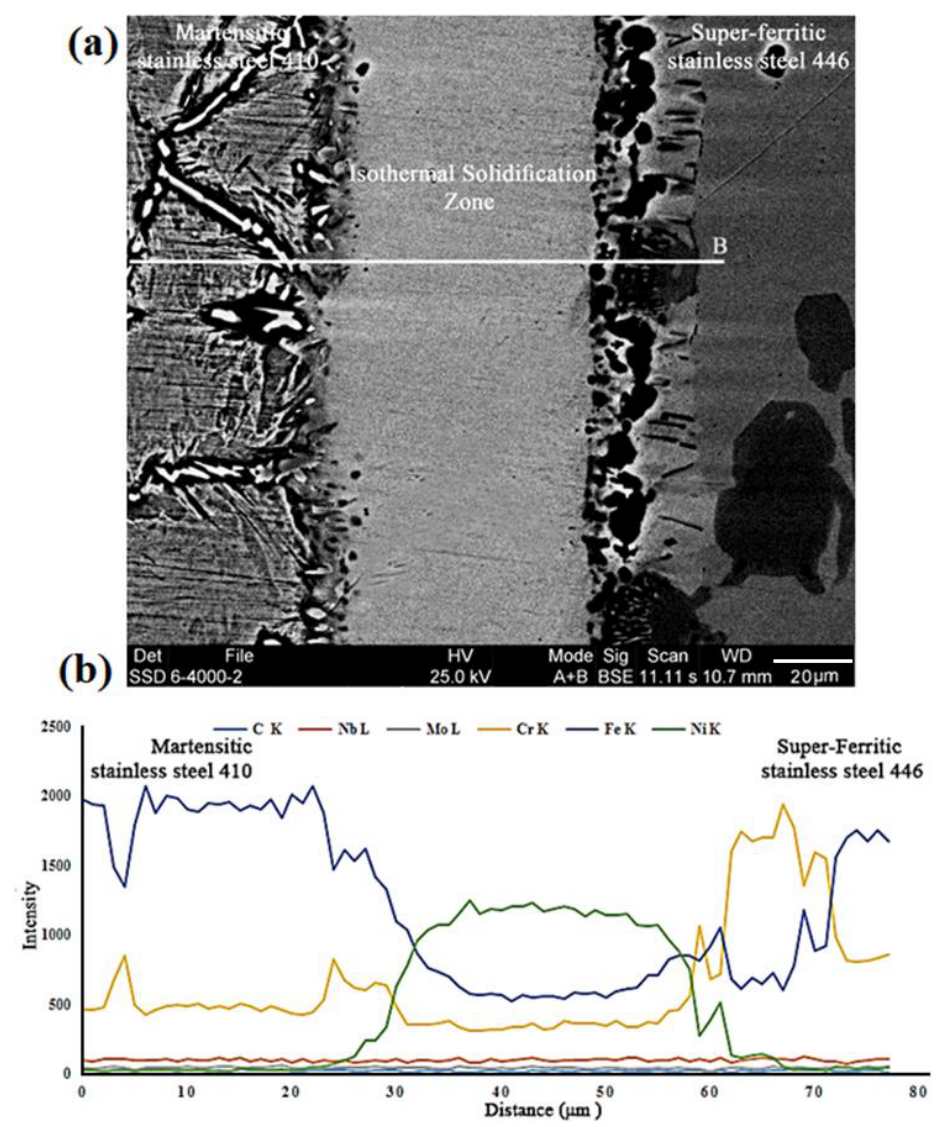
Figure 7. ( a ) The SEM micrograph and ( b ) line scans across the TLP bonded sample at 1050 °C /60 min condition.